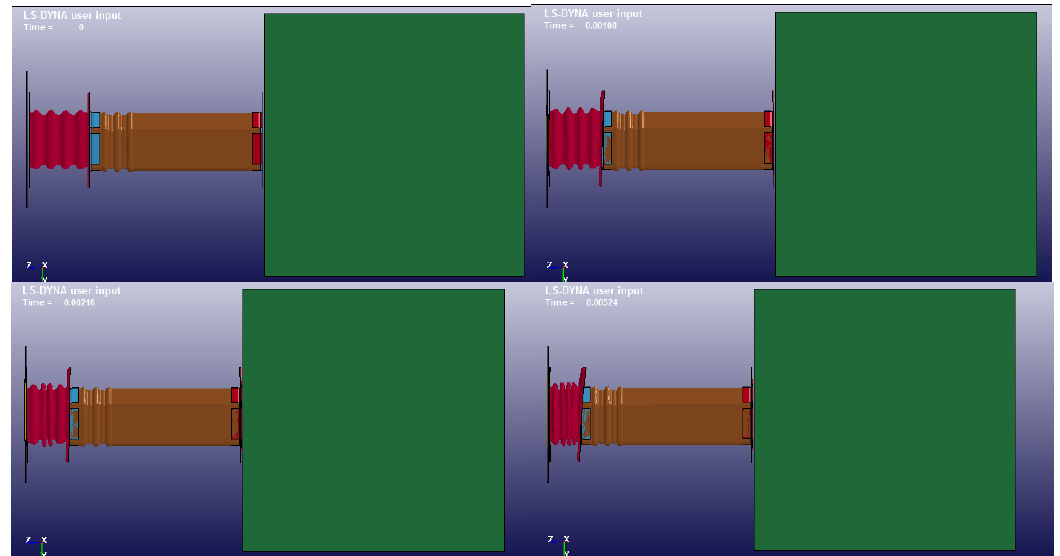
Figure 13. Cont. Figure 13.